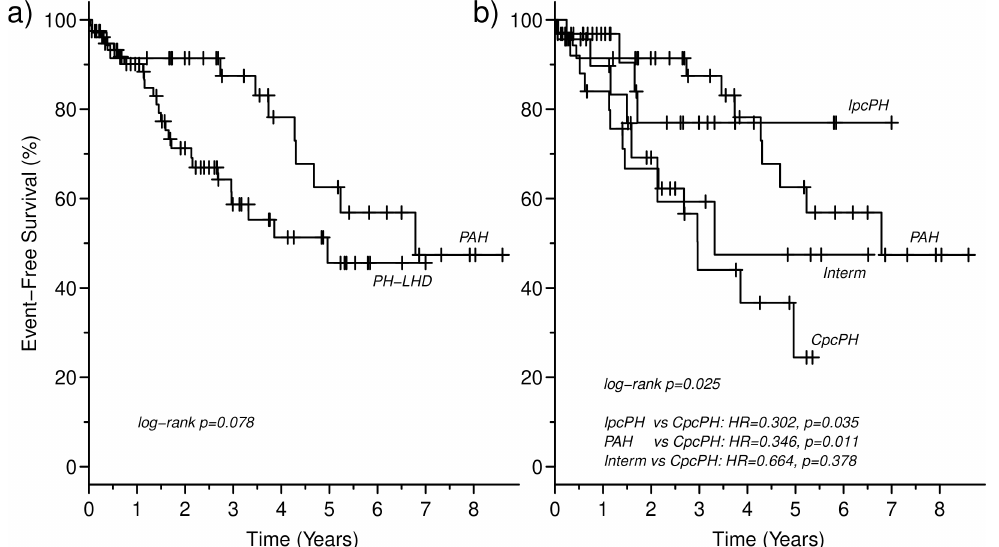
Fig 3. Kaplan-Meier curves of survival for patients with pulmonary arterial hypertension and patients with pulmonary hypertension due to left heart disease. In the panel a) patients with pulmonary hypertension due to left heart disease are all pooled together, while in the panel b) they are subdivided in three groups according to the diastolic pressure gradient and pulmonary vascular resistance. CpcPH = combined post- and pre-capillary pulmonary hypertension; Interm = intermediate PH-LHD; IpcPH = isolated post-capillary pulmonary hypertension; PAH = pulmonary arterial hypertension; PH-LHD = pulmonary hypertension due to left heart